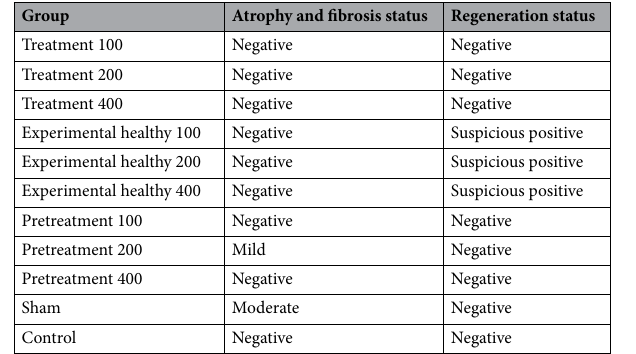
Table 4. Histopathological results in the studied rats.